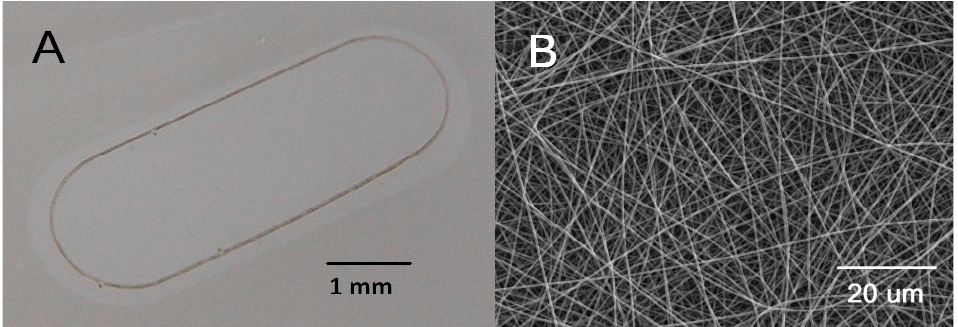
Figure 1. Nanofibrous carrier with embedded supporting PET frame. The carrier was cut from a cell culture insert with a modified punch. Three visible marks on the frame allow to control a side orientation of the carrier ( A ). Electron microscopy of the nanofibrous membrane ( B ). The diameter of the bead-free fibres was 380 nm (standard deviation, SD 10 nm) and the average pore size of the membrane was 0.4 µm (SD 0.2 µm). The membrane was 3.7 µm in thickness and its porosity was estimated to be 72% [18].